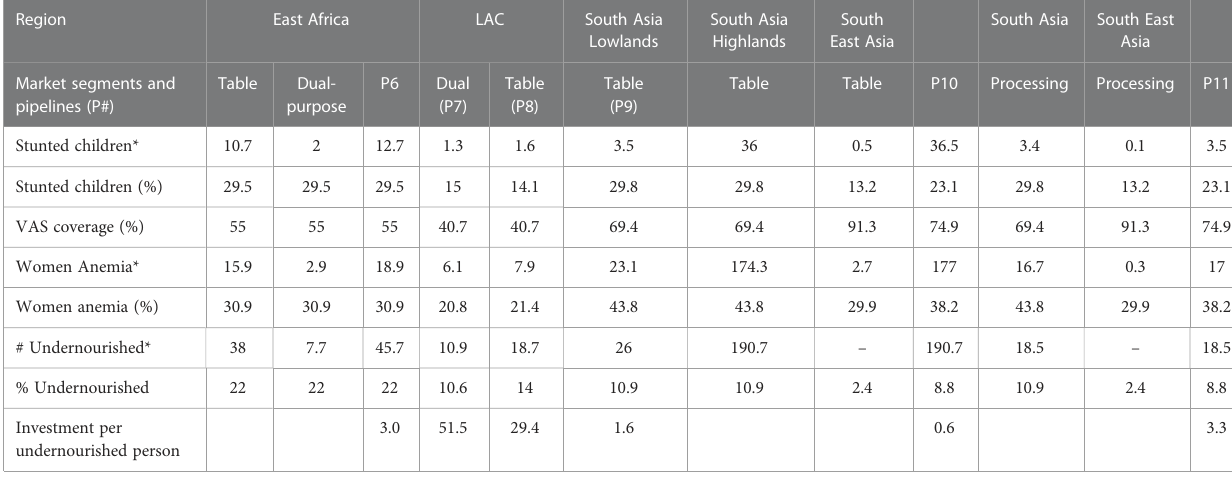
TABLE 6 Nutrition status in the potato market segments. Region